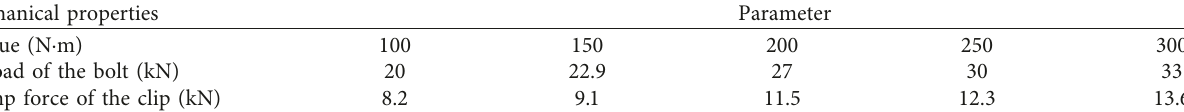
Table 2: Parameter set.